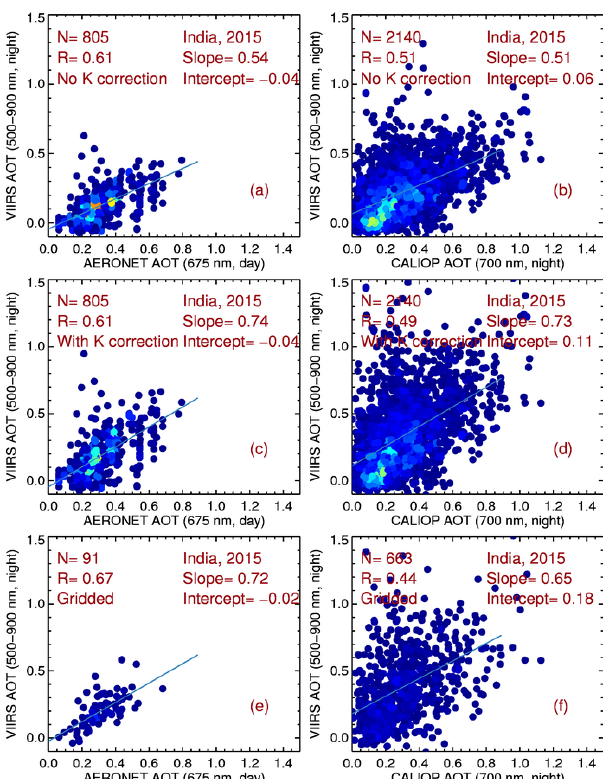
Figure 8. Similar to Fig. 7 but for the Indian region for 2015. Ar- tificial light sources from the state of Uttar Pradesh in India are excluded.